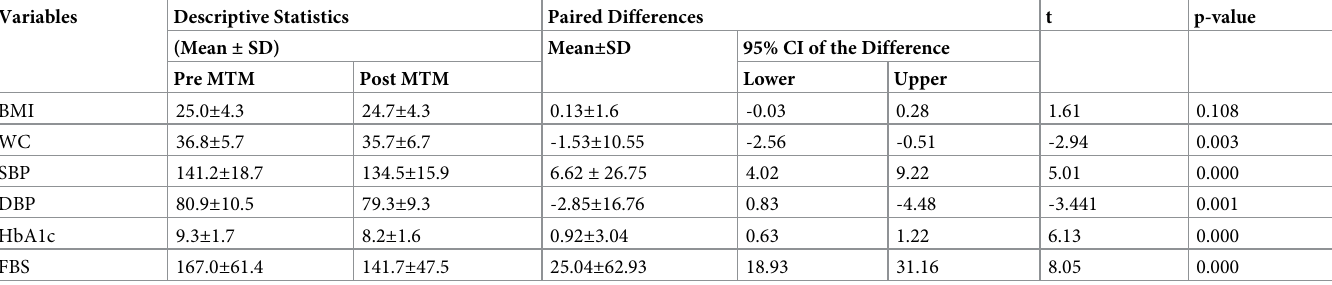
Table 2. Clinical measures for mean scores and paired samples t-test for clinical outcome measures among adult diabetic patients. Variables Descriptive Statistics